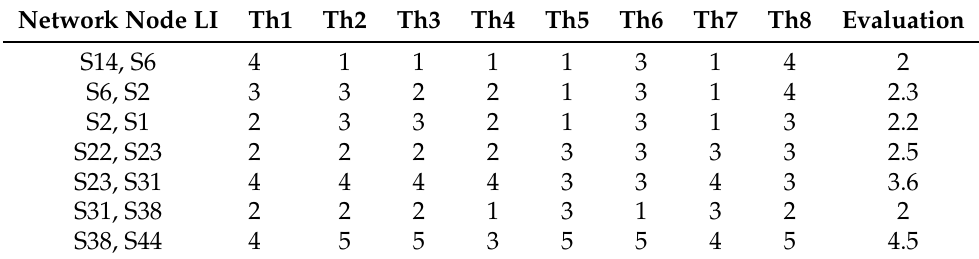
Table 8. Vulnerability evaluation simulation scenario: Path Security Level from hosts H1 to H14. Evaluation’s result (average):